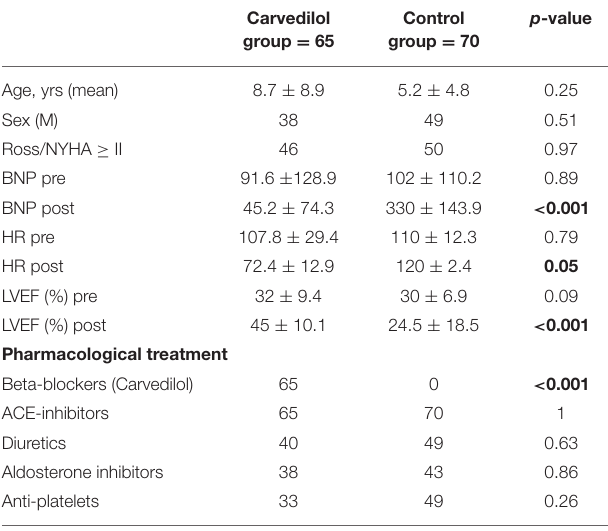
TABLE 1 | Characteristics of